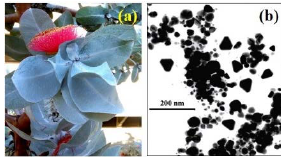
Figure 2. Au nanoparticles synthesised using Eucalyptus macrocarpa leaf extract. ( a ) Plant and ( b ) typical transmission electron microscopy image [84].